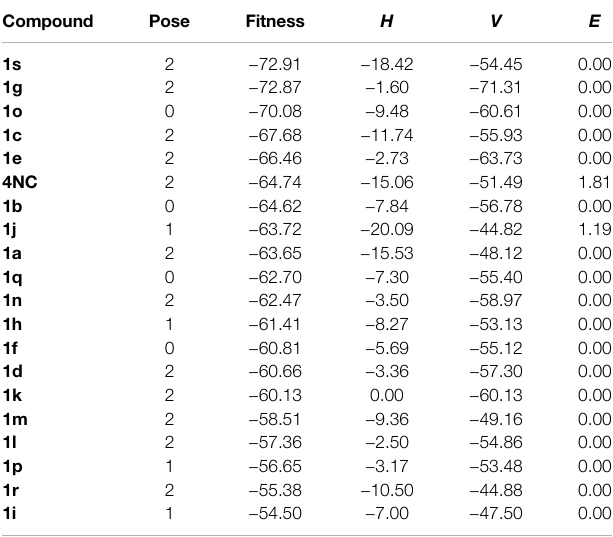
TABLE7| Totalenergiesofapredictedposes( fi tness)andenergiesofinteractions (hydrogen-bonding ( H ), van der Waals ( V ), and electrostatic ( E )) between protein residue and ligand (kcal mol − 1 ) in the binding site of soybean LOX-3 (1NO3). Compound